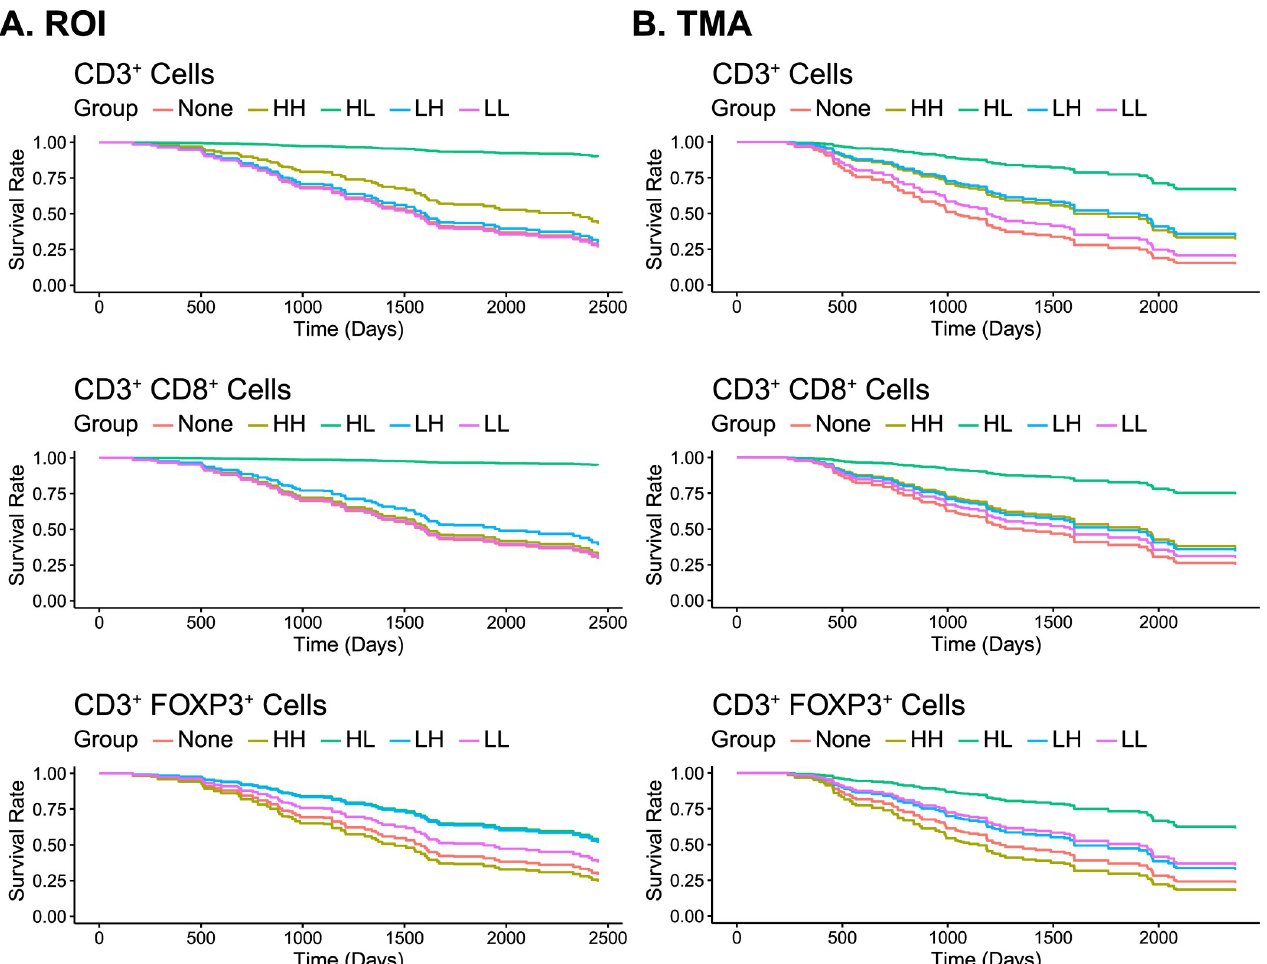
Fig 3. Predicted survival curves from Cox proportional hazard models for the CD3+, CD3+CD8+, and CD3+FOXP3+ cells where the degree of spatial clustering was based the permutation-based estimate of Ripley’s K under CSR (i.e., observed Ripley’s K–the mean of the empirical distribution of Ripley’s K under CSR); (A) results from intra-tumoral ROIs (93 subjects, 260 samples); (B) results from tumor compartment of TMAs (94 subjects, 263 samples). Models adjusted for age at diagnosis and stage within a repeated measures analysis